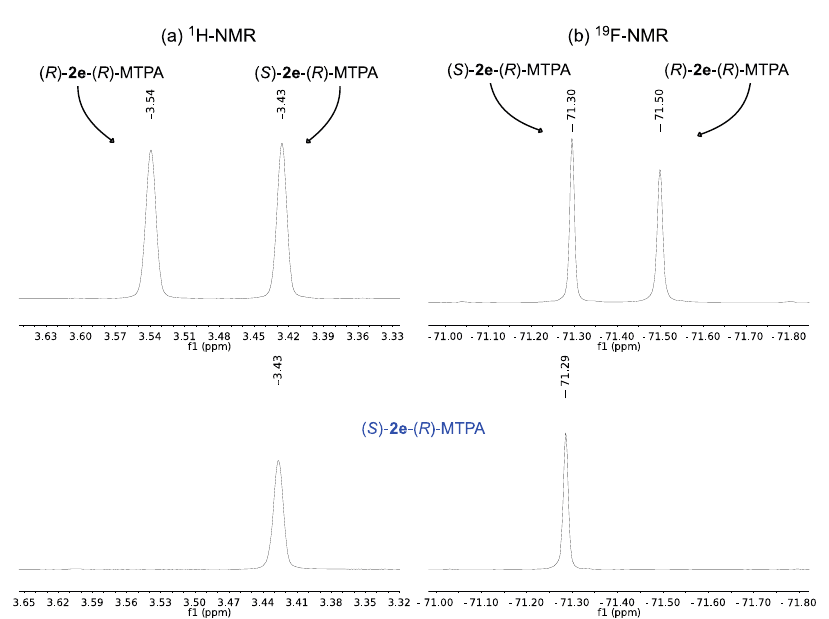
Figure 2. ( a ) 1 H-NMR of the methoxy region of ( R )-MTPA esters of rac - 2e (above) and ( R )-MTPA ester of ( S )- 2e (below); ( b ) 19 F-NMR of ( R )-MTPA esters of rac - 2e (above) and ( R )-MTPA ester of ( S )- 2e (below).